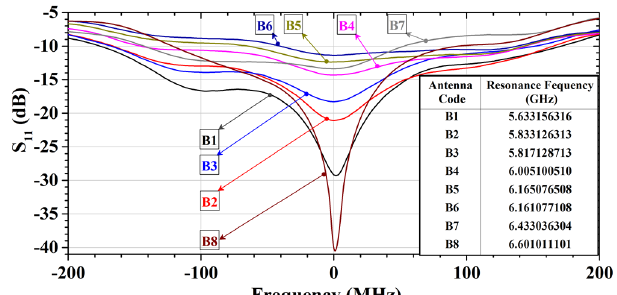
Figure. 3. Measured magnitude of S 11 for various SFs in 400MHz span around the resonant frequency of various antennas.